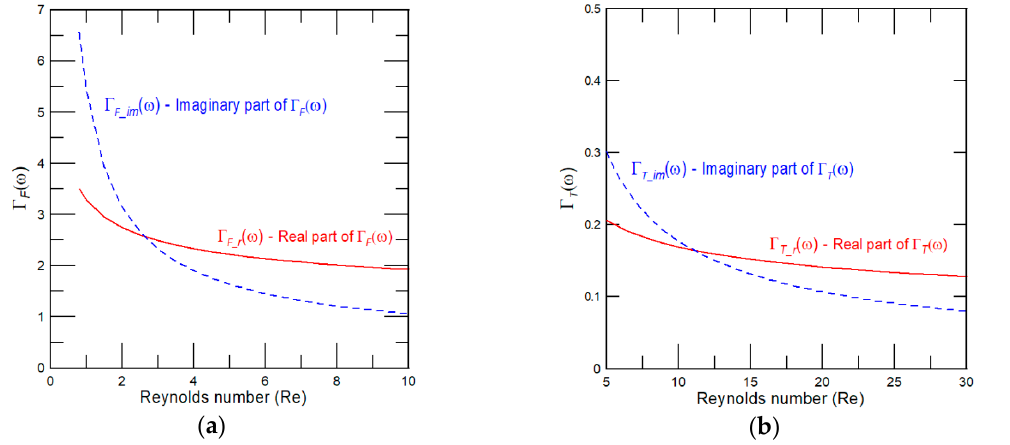
Figure 2. Calculated dependencies of the real and imaginary components of the hydrodynamic function on the fundamental resonant frequency of a rectangular two-layered microcantilever (see Figure 1) immersed in air, represented through the Reynolds number for ( a ) flexural and ( b ) torsional oscillations.